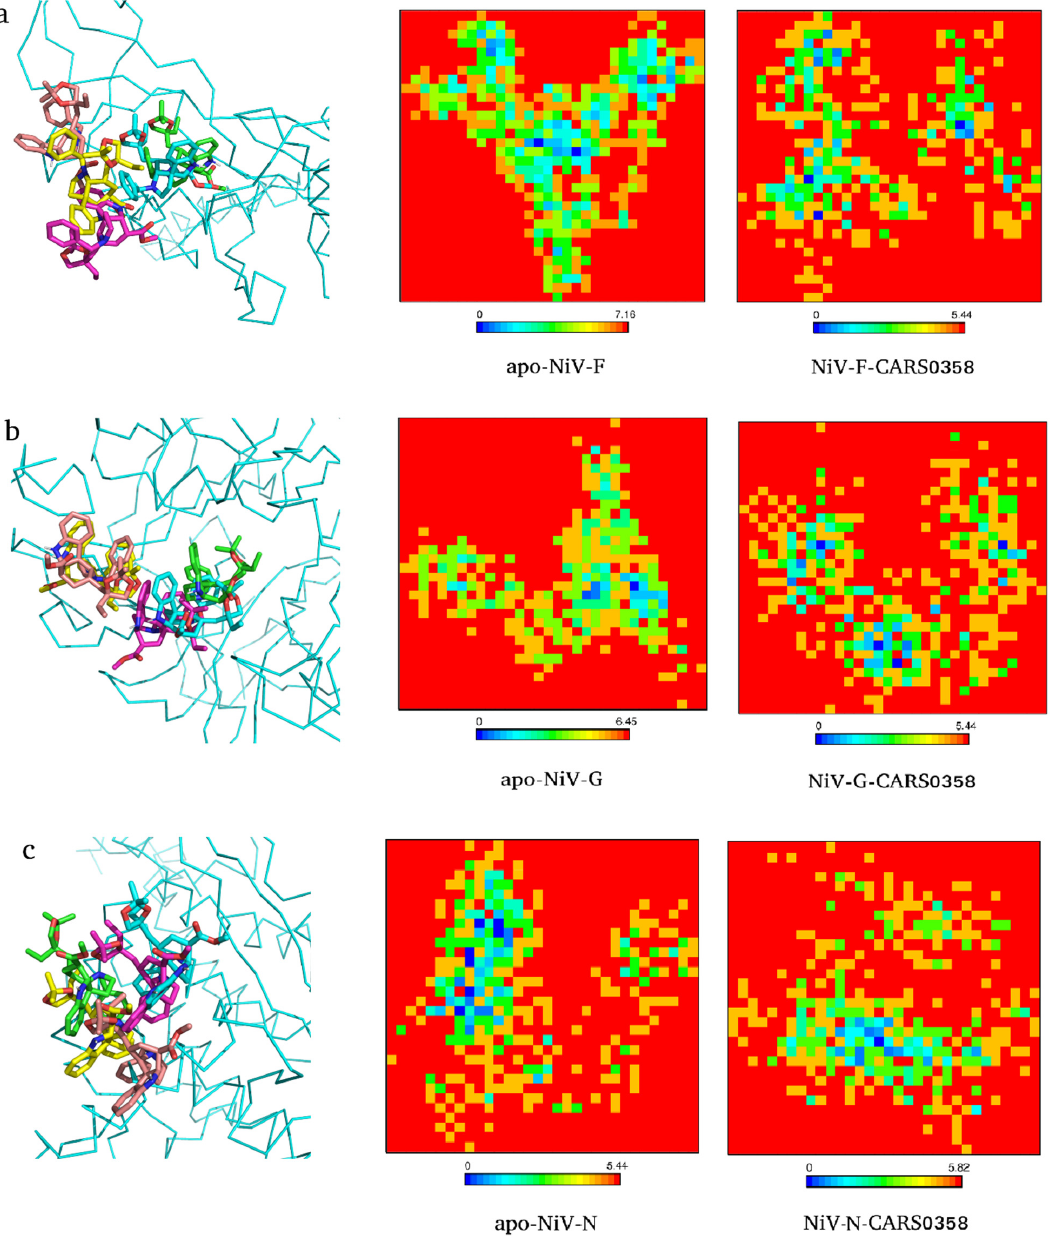
Figure 6. Conformations (1 ns (green), 2 ns (cyan), 3 ns (pink), 4 ns (yellow), and 5 ns (brick)) of molecule CARS0358 inside binding pockets of NiV-F ( a ), NiV-G ( b ), and NiV-N ( c ) during whole MD simulations (left panel). The respective 2D graphs of the Gibbs free energy landscape for apo- (middle panel) and final ligand-bound conformation (right panel) are also provided.